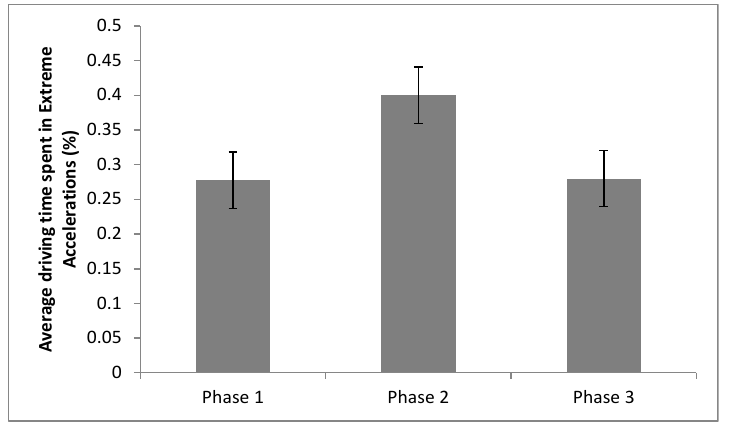
Figure 4. Average percentage of driving time in Extreme